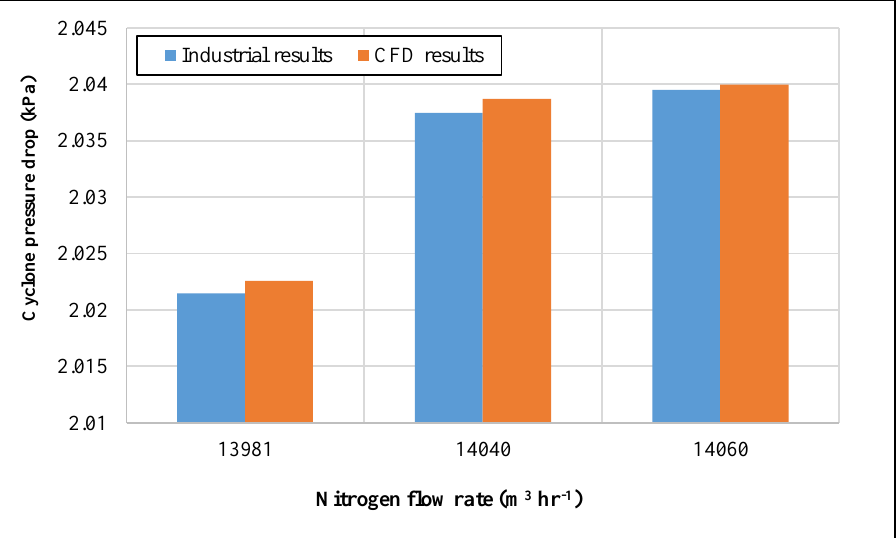
Figure 5. 2D map cyclone pressure drop versus N2 flow rate at